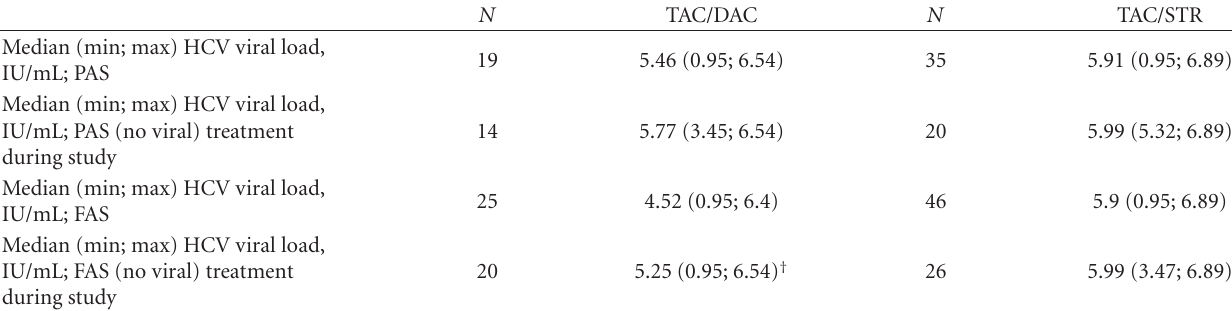
Table 2: Measurement of median (min; max) HCV viral load at month 12 in patients completing the study ∗ .